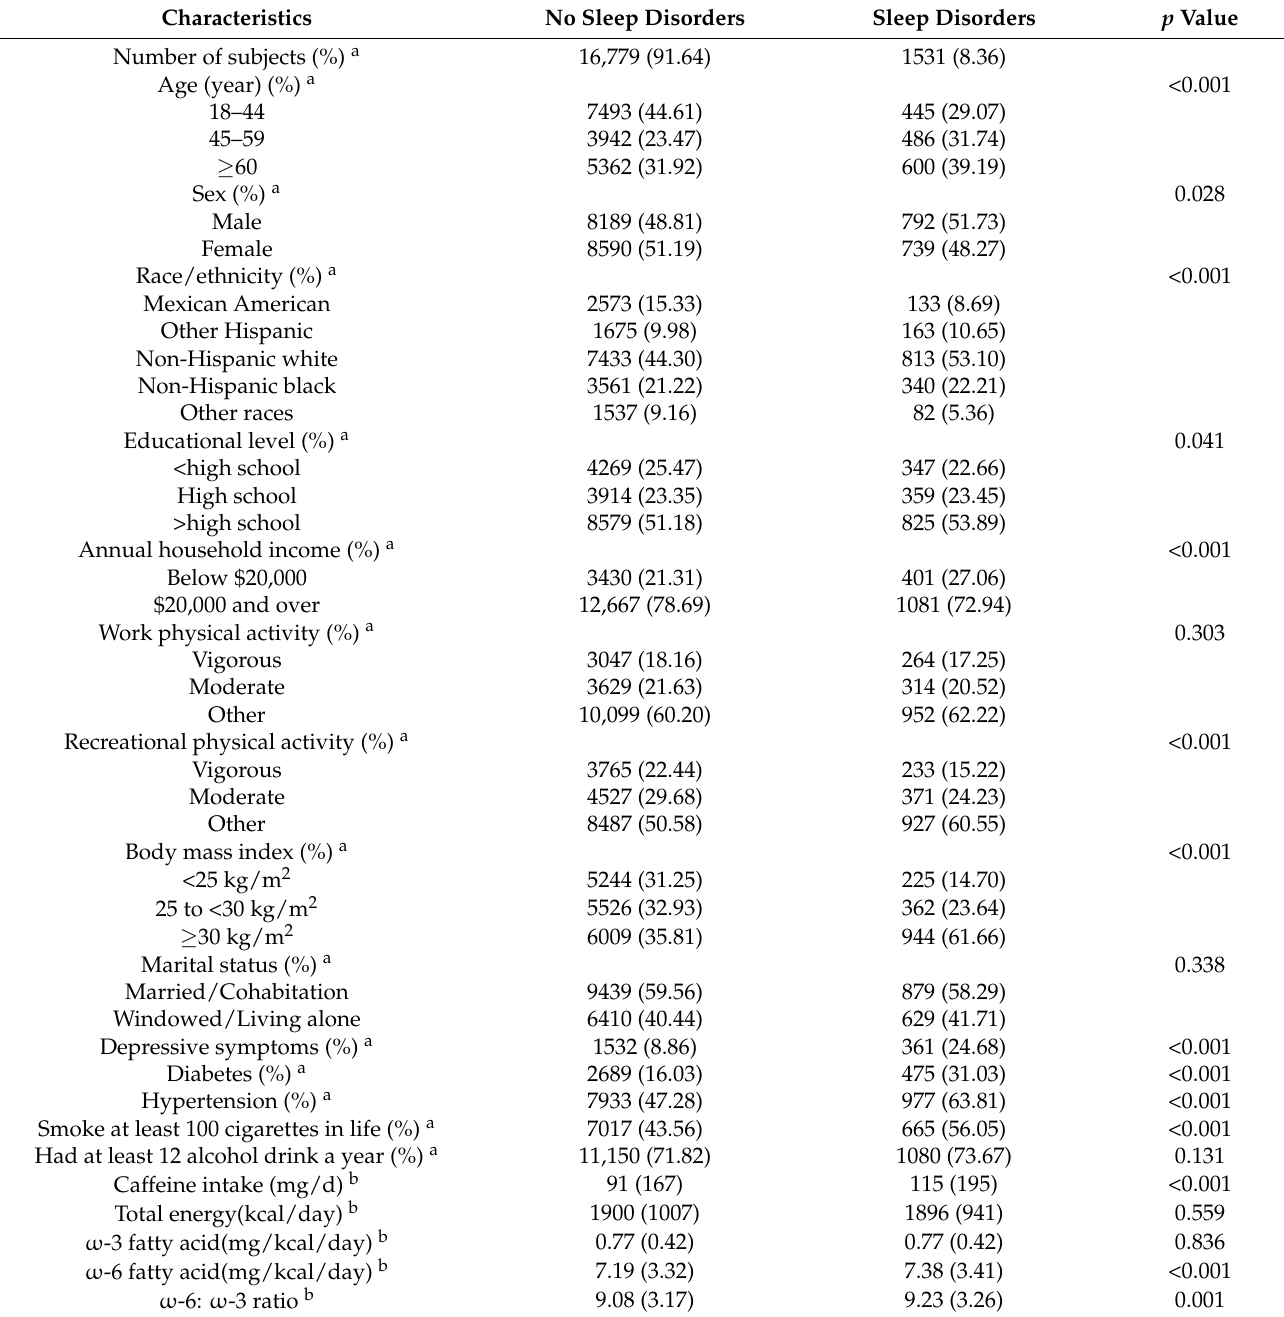
Table 1. Characteristics of participants by sleep disorders, NHANES 2007–2014 (n =18,310).